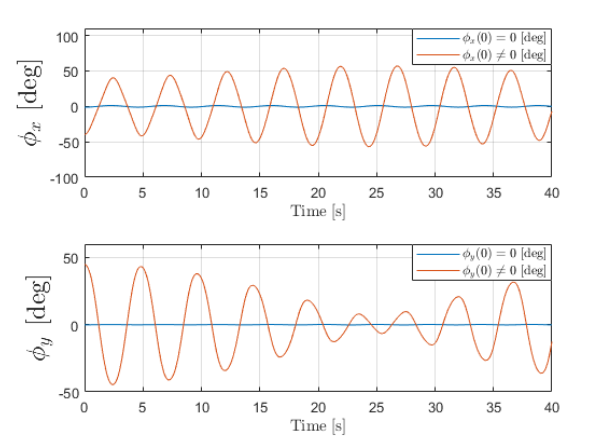
Figure 9: Red graph shows the orientations [ φ x , φ y ] of the swinging pendulum with initial con- ditions [ φ x (0) , φ y (0)] ≈ [ − 45 ◦ , 45 ◦ ]. The blue graph shows the orientations [ φ x , φ y ] of the pendulum with initial conditions [ φ x (0) , φ y (0)] ≈ [0 ◦ , 0 ◦